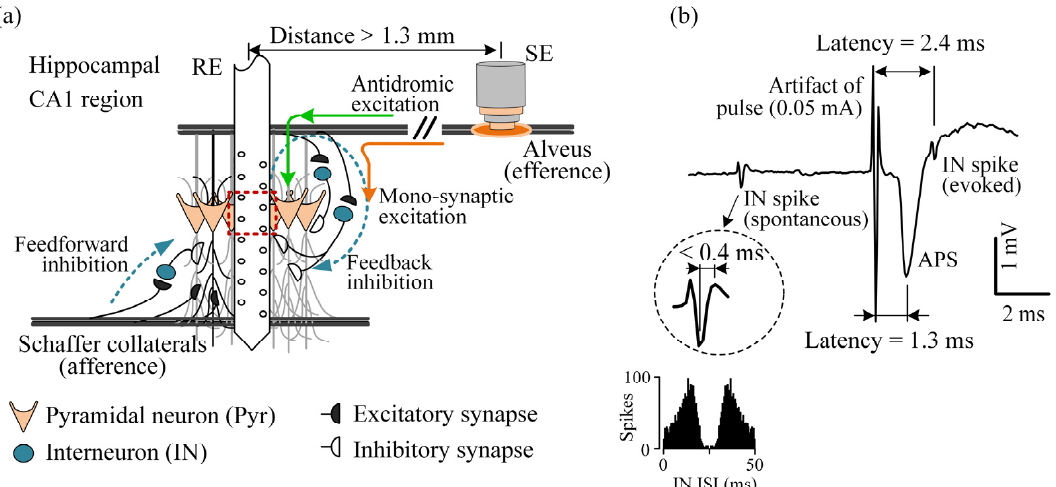
Figure 1. Responses of pyramidal neurons (Pyr) and interneurons (IN) to the antidromic stimulation at the alveus in the rat hippocampal CA1 region. ( a ) Schematic diagram of the local inhibitory neural circuits and the electrode locations. The Pyrs accept inhibitory input from both feedforward (denoted by the blue arrow on the left) and feedback (denoted by the blue arrow on the right) inhibitory circuits. The INs in the inhibitory circuits are activated by excitatory synapses (solid semicircles) and then act on the somata or dendrites of Pyrs via inhibitory synapses (hollow semicircles). The excitation generated by an electrical pulse applied at the alveus (axons of the Pyrs) by the stimulation electrode (SE) can propagate antidromically along the axons and then activate the somata of the Pyrs (green curve with arrows). Simultaneously, the excitation may activate the INs in the feedback inhibitory circuits via monosynaptic transmissions (orange curve with arrow). The red dashed box denotes the channels on the recording electrode (RE) located in the pyramidal layer of CA1 region. ( b ) Antidromically-evoked population spike (APS) and a unit spike of an IN evoked by a single-pulse stimulation at the alveus. The expanded waveform of a typical IN spike and the histogram of inter-spike-intervals (ISI) of IN spikes in the baseline state were used to identify the IN firing.